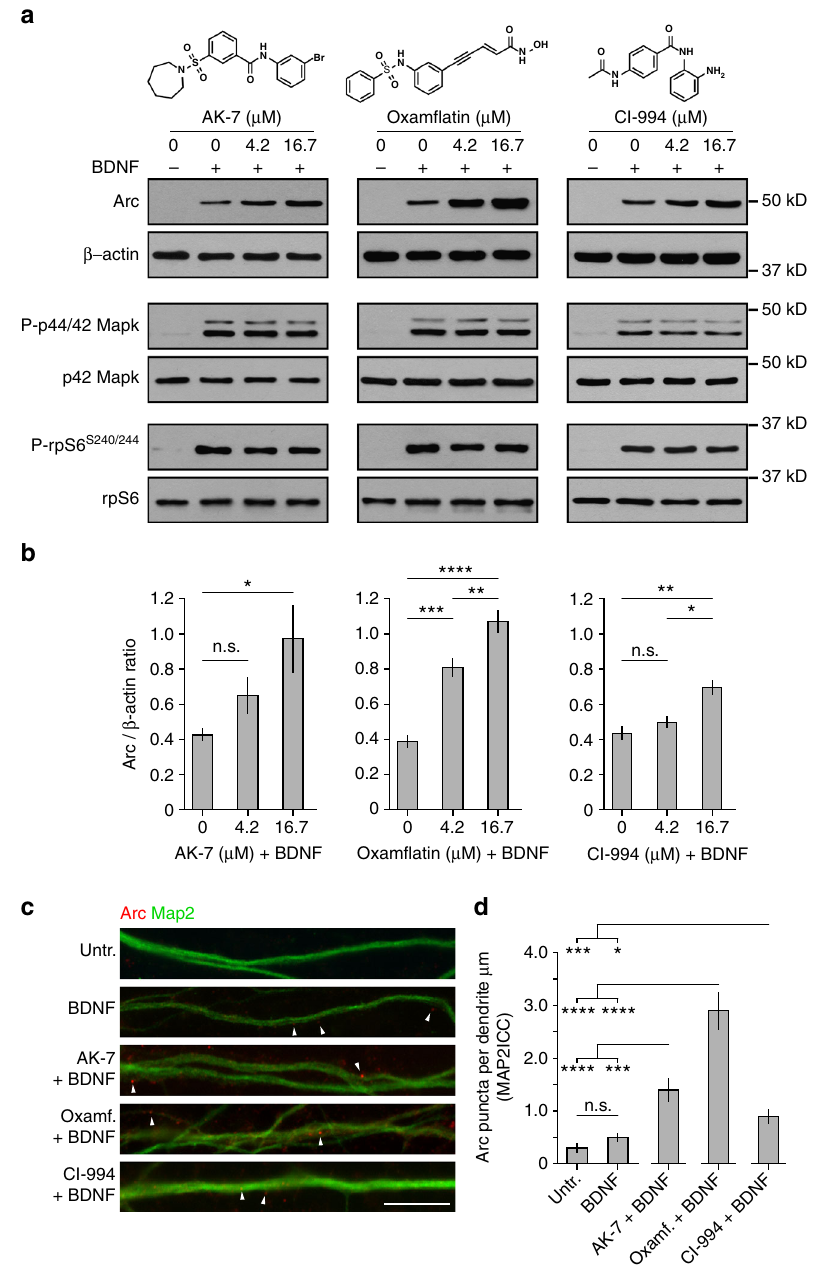
Fig. 4 Post-screen validation of KDAC inhibitors AK-7, oxam fl atin, and CI-994 potentiating effect on Arc protein abundance. a Western blot analysis reveals that lysates from BDNF-treated cortical cultures supplemented with AK-7, oxam fl atin, or CI-994 have signi fi cantly more total Arc protein than BDNF plus vehicle (DMSO) control condition. Chemical structure of each compound is presented on top. b Graphs show mean ( n = 5) Arc/ β -actin ratio ( ± SEM) for cells treated as in a . One-way ANOVA revealed a signi fi cant dose – response difference between compound concentrations (AK-7, F 2,12 = 4.48, p < 0.05; oxam fl atin, F = 46.72, p < 0.0001; CI-994, F = 12.24, p < 0.005). Tukey ’ s HSD post hoc test, * p < 0.05; ** p < 0.01, *** p < 0.005; **** p < 2,12 2,12 0.0001. Western blots run with the same sample lysates revealed that these three KDAC inhibitors do not alter BDNF-dependent phosphorylation of p44/ 42 Mapk and rpS6. c Each tested KDAC inhibitor increases number of Arc puncta along dendrites labeled by Map2 immunocytochemistry. Representative captures of DIV14 mouse primary cortical neurons from each experimental condition co-immunostained for Arc (red fl uorophore) and Map2 (green fl uorophore). White arrowheads show examples of discrete Arc puncta. Primary cortical neurons were treated with BDNF and AK-7, oxam fl atin, or CI-994 at a fi nal concentration of 16.7 µ M. Scale bar 10 µ m. d Graph shows mean Arc puncta per dendrite µ m for cells treated as in c . Separate ANOVA revealed a signi fi cant difference between cells co-treated with a KDAC and BDNF over untreated and BDNF alone conditions (AK-7, F 2,82 = 12.82, p < 0.0001; oxam fl atin, F 2,78 = 46.31, p < 0.0001; CI-994, F 2,82 = 8.08, p < 0.001). Tukey ’ s HSD post hoc test, * p < 0.05; *** p < 0.005; **** p <